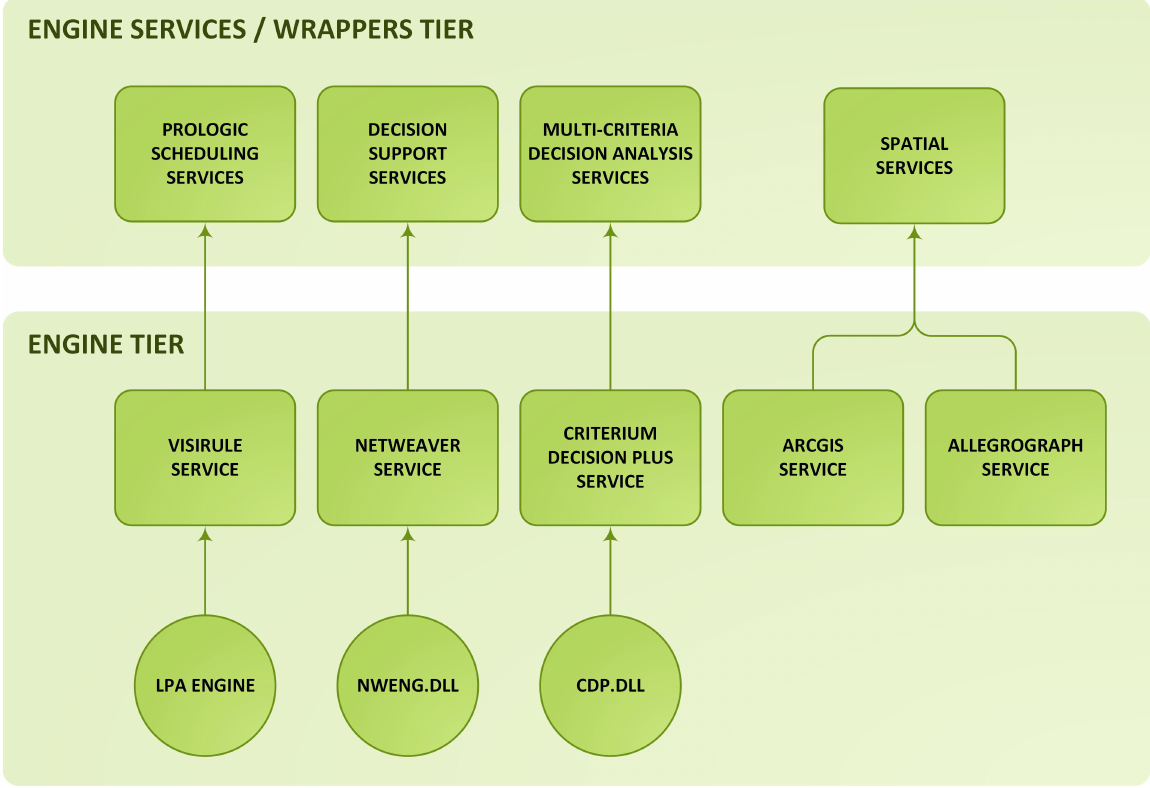
Figure 2. Engine Services Tier. NET wrappers provide the interface to each engine in this